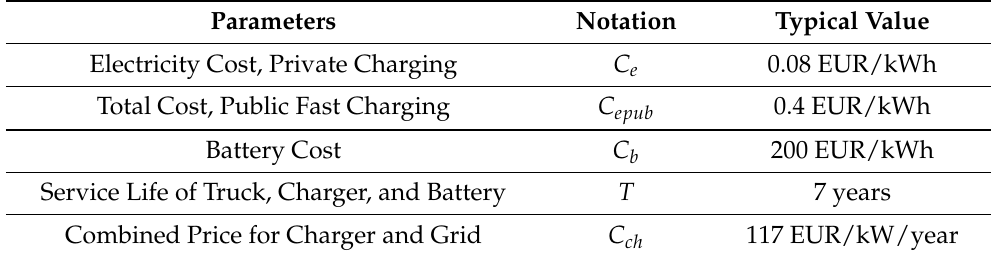
Table 2. Cost parameters and their values used in this